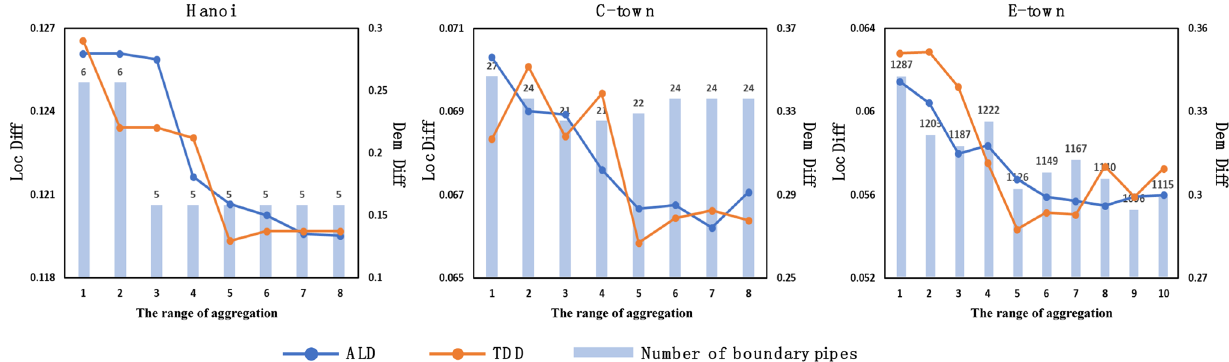
Fig. 6 Influence of aggregation range on LocDiff, DemDiff, and boundary pipe number in the networks of Hanoi (left), C-town (middle), and E-town (right).